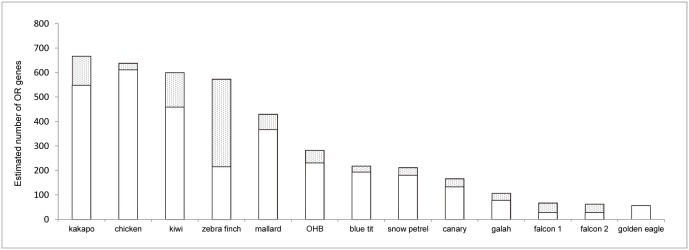
The estimated OR gene repertoire sizes of 13 species of birds representing eight orders.Open and grey bars represent the estimated total number of functional and non-functional OR genes, respectively. Data are from this study (OHB = Oriental honey buzzard), Warren et al. [41] (zebra finch), Zhan et al. [42] (falcon 1 = peregrine falcon, falcon 2 = saker falcon), Doyle et al. [43] (golden eagle) and Steiger et al. [38] (all other species). Note that Doyle et al. [43] did not distinguish between the number of functional and non-functional OR gene.